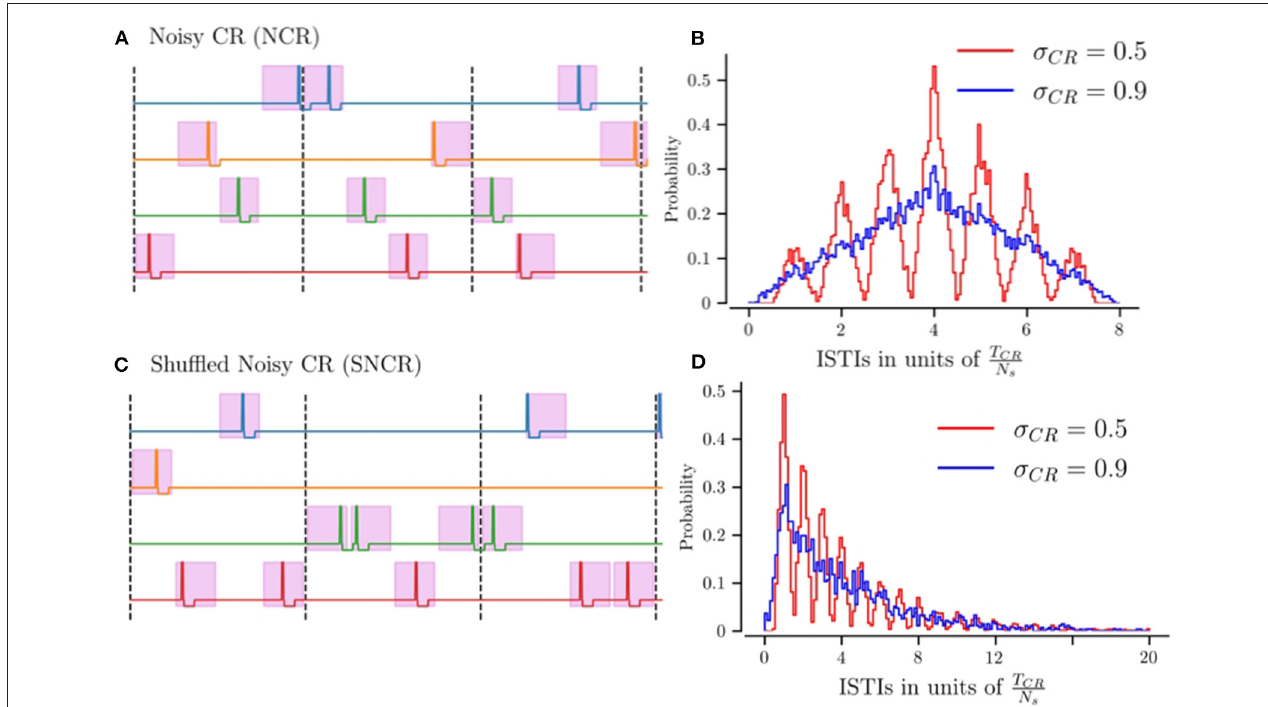
FIGURE 1 | Illustration of stimulation patterns used throughout the manuscript and the resulting distribution of inter-stimulus intervals. (A) Possible realization of NCR stimulation for N s = 4 stimulation sites. Colored curves indicate the stimulation currents delivered to the individual sites. The pink region marks intervals of possible stimulus onset times, for the maximum jitter σ CR = 1. The limit of vanishing jitter, σ CR = 0, corresponds to deterministic stimulus onsets, i.e., CR stimulation. Vertical dashed lines separate subsequent CR cycles, with cycle period T CR = 1 / f CR . (B) The distribution of inter-stimulus intervals (ISTIs) for NCR stimulation for two values of stimulus jitter, σ CR . (C) Possible realization of SNCR stimulation with N s = 4 stimulation sites. The color code is the same as in (A) . (D) The distribution of ISTIs for SNCR stimulation for two values of σ CR